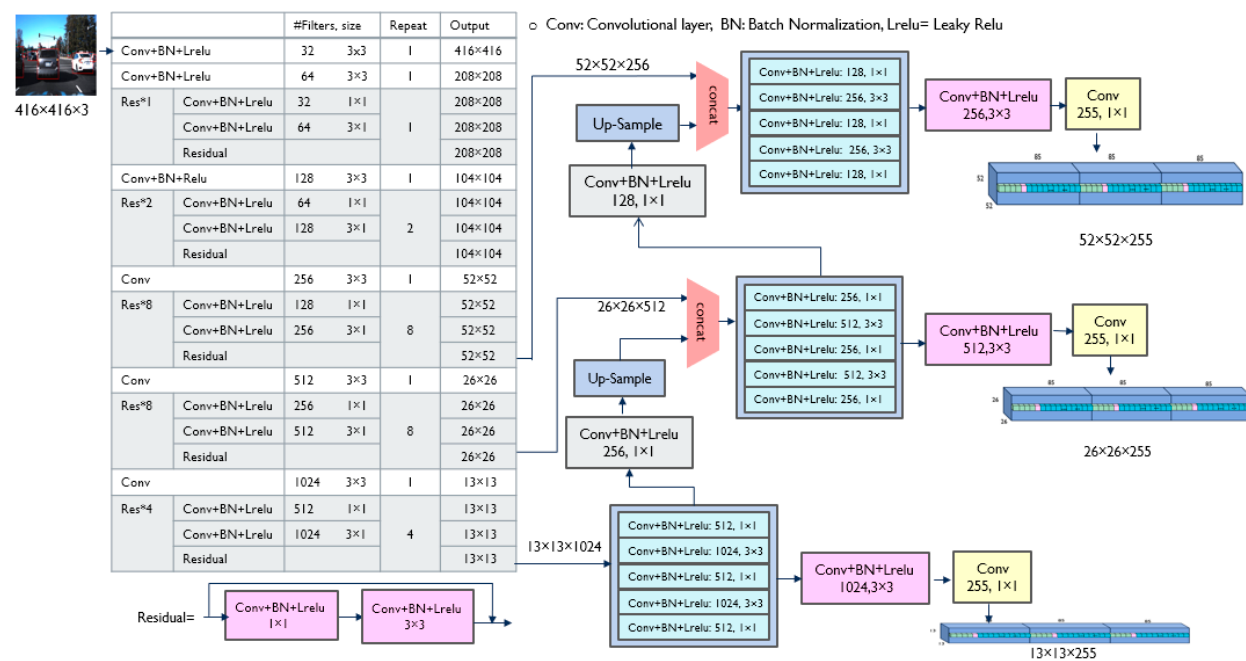
Figure 2. The architecture of YOLOv3. Note: # filters = the number of filters.